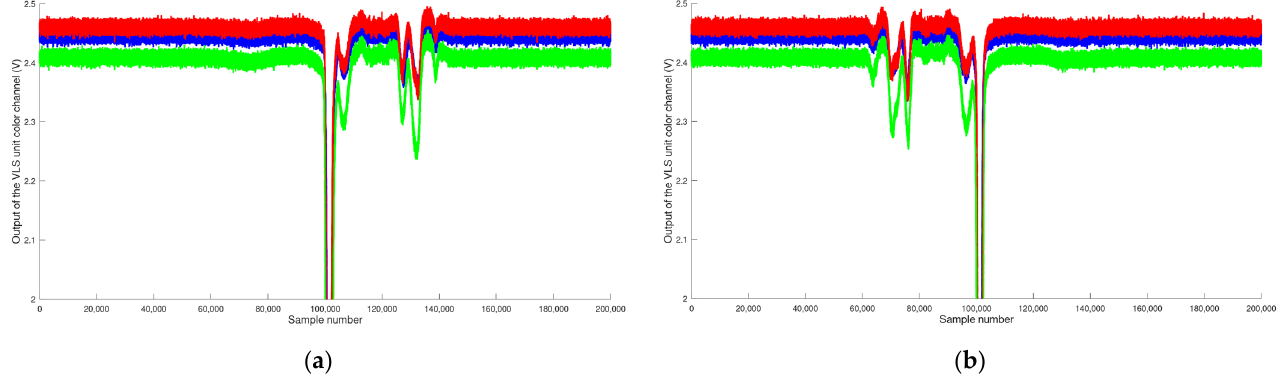
Figure 4. Outputs of the color channels (V) of the VLS unit. ( a ) Train with only the ME attached, moving in the Forward direction with Speed 3. ( b ) Train with only the ME attached, moving in the Backward direction with Speed 3.